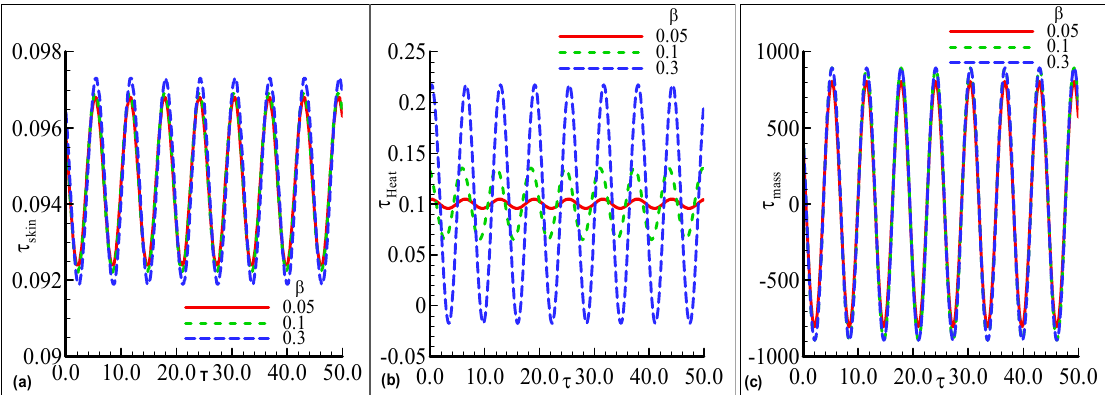
Figure 6. The physical profiles for 𝜏 (cid:3046)(cid:3038)(cid:3036)(cid:3041) , 𝜏 (cid:3035)(cid:3032)(cid:3028)(cid:3047) , and 𝜏 (cid:3040)(cid:3028)(cid:3046)(cid:3046) with choices of 𝛽 (cid:3404) 0.05, 0.1, and 0.3 and fixed Pr (cid:3404) 7.0 , 𝑆 (cid:3030) (cid:3404) 0.2 , 𝜆 (cid:3047) (cid:3404) 0.4 , 𝜆 (cid:3030) (cid:3404) 0.6𝐸 (cid:3404) 0.7 , 𝛾 (cid:3404) 0.3 , 𝜆 (cid:3404) 0.2 , 𝑛 (cid:3404) 0.3, and 𝜖 (cid:3404) 0.05 . The amplitude of oscillation in 𝜏 (cid:3046)(cid:3038)(cid:3036)(cid:3041) , 𝜏 (cid:3035)(cid:3032)(cid:3028)(cid:3047), and 𝜏 (cid:3040)(cid:3028)(cid:3046)(cid:3046) under the influence of the